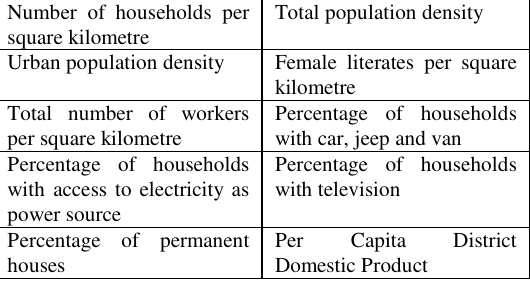
Total population density kilometre Percentage of households with car, jeep and van Percentage of households with television Per Capita District Domestic Product